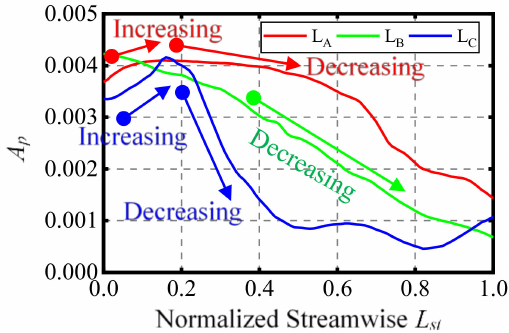
Figure 19. Streamwise lines amplitude of A p